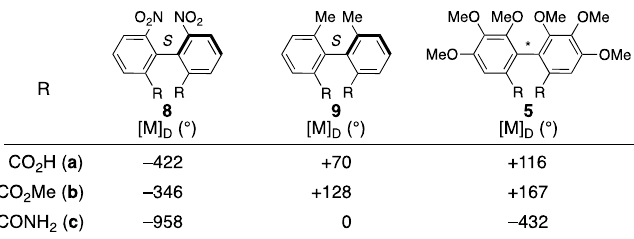
Figure 4. The data used for the determination of the S -axial chirality in the second structure of corilagin.